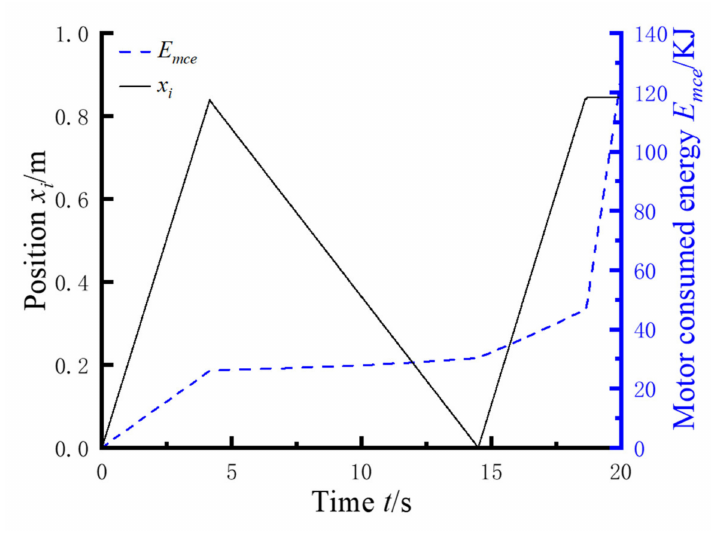
Figure 21. Load position and motor energy consumption under optimized parameter conditions.